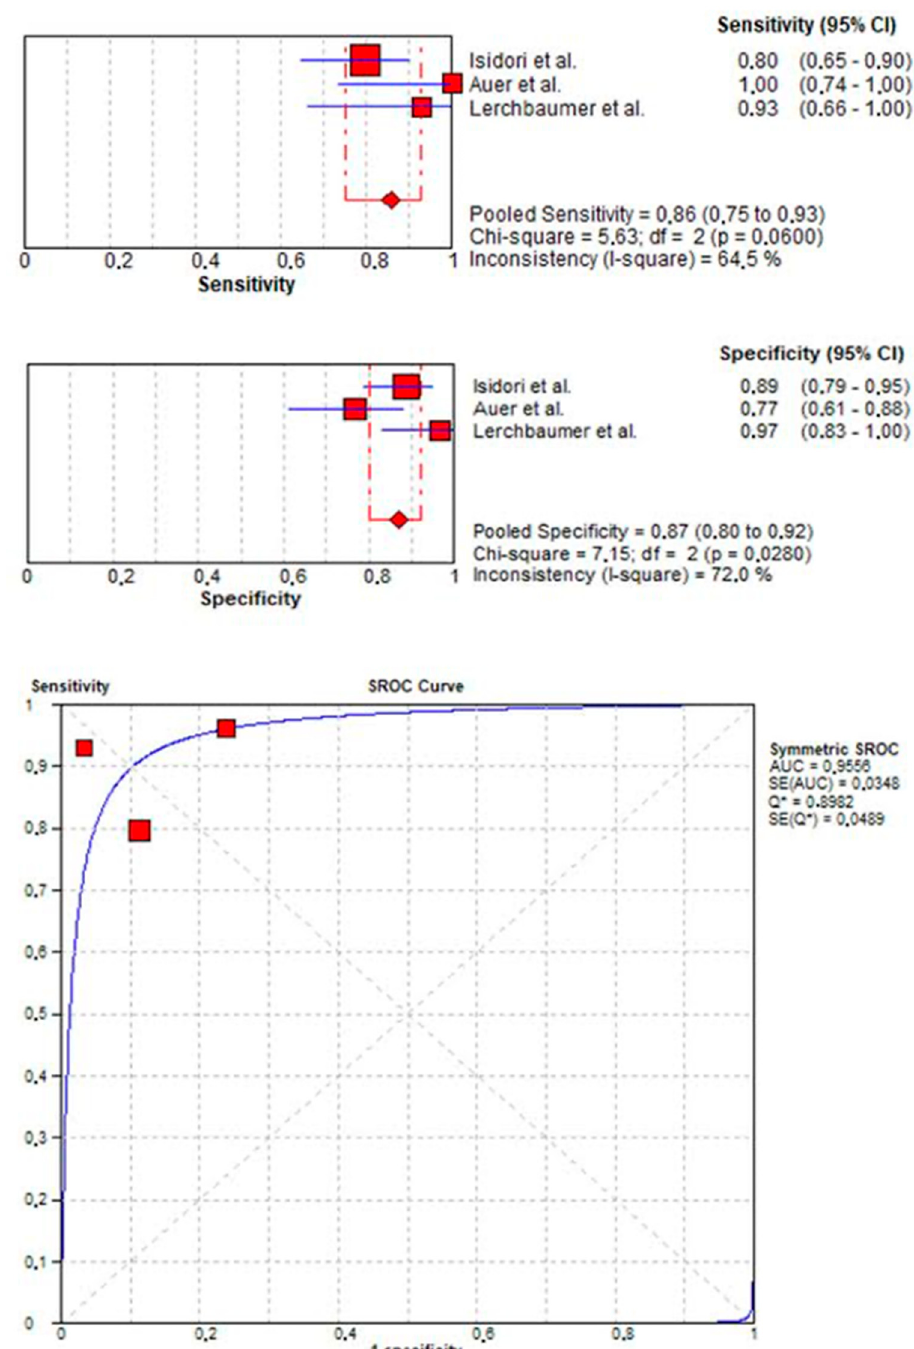
Figure 3. Pooled sensitivity, specificity, and SROC curve of CEUS in detecting malignant lesions.